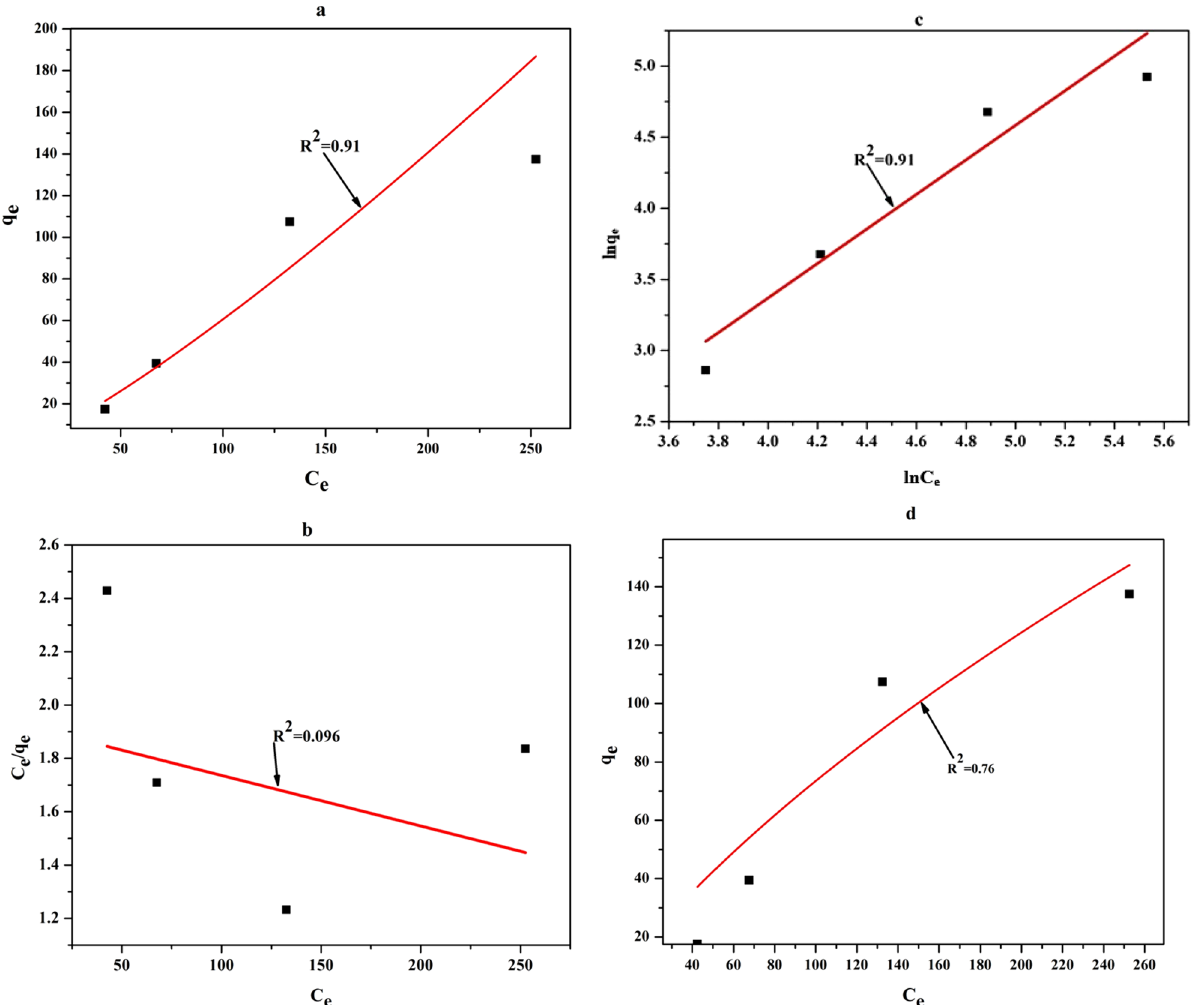
Figure 14. Plot of isotherms for adsorption of Cu 2+ ions on